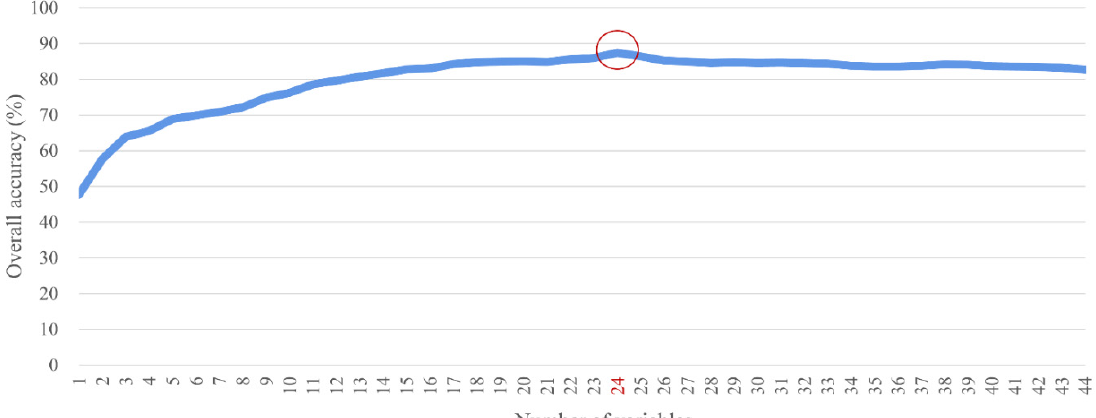
Figure 5. Changes in the OA values of land cover classification associated with different number of input variables.